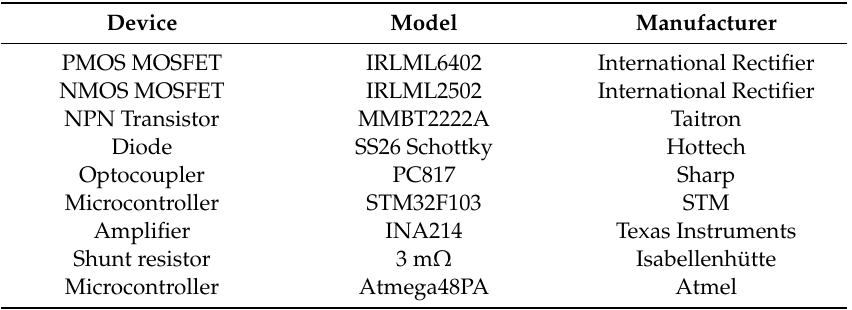
Table 1. Device information.